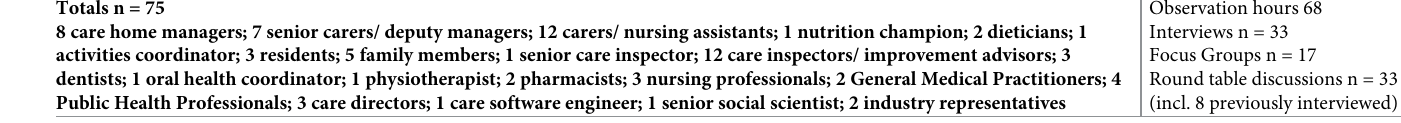
Round table discussion: care staff, oral health educators, dental public health professionals Round table discussion: care staff, staff nurse, nursing assistant, GP, pharmacist Round table discussion: care staff; activities coordinator; software designer Round table discussion: care staff; nutrition coordinator, nursing academic Round table discussion: care staff; software designer; care sector representative